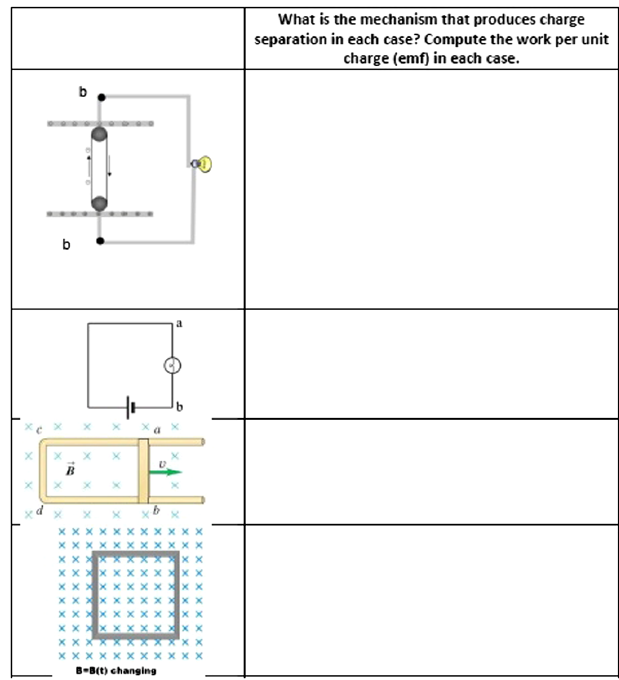
FIG. 5. Worksheet of activity A3 of TLS2 in which students complete the